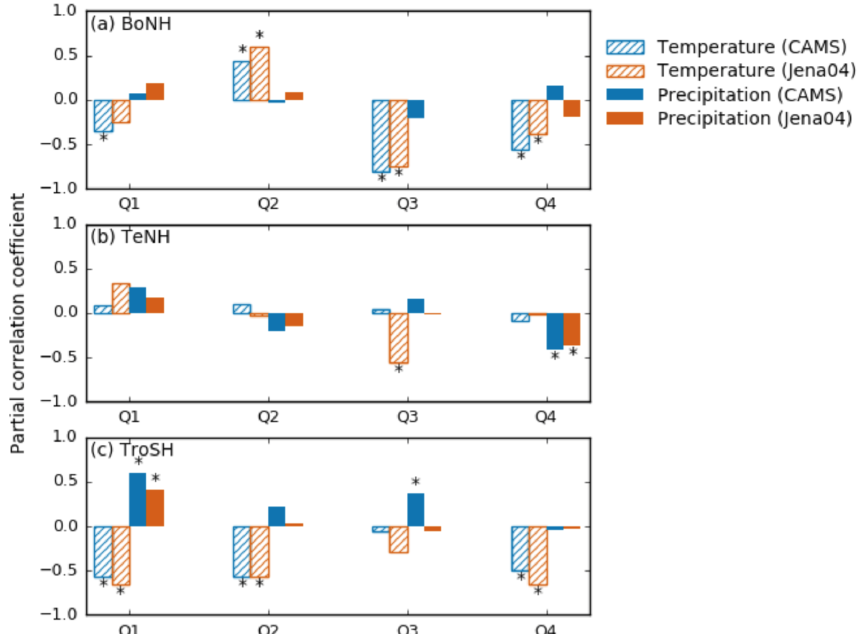
Figure 4. Partial correlation coefficients of detrended annual anomalies of land carbon fluxes by CAMS and Jena04 inversions against the anomalies in temperature and precipitation of different seasons ( n = 34). An asterisk indicates significant correlation ( p< 0 .